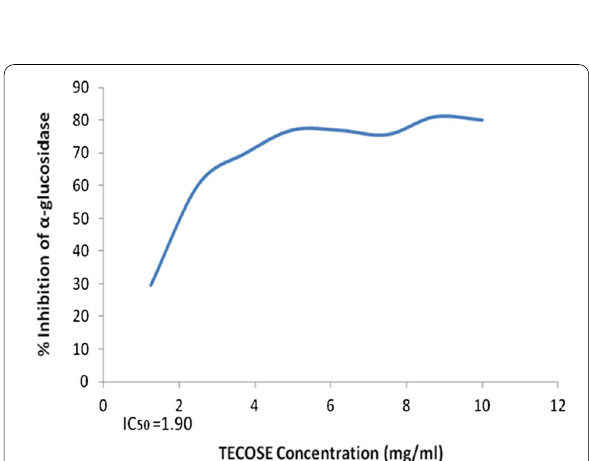
Fig. 5 Percentage inhibition of α-glucosidase by Tetracarpidium conophorum